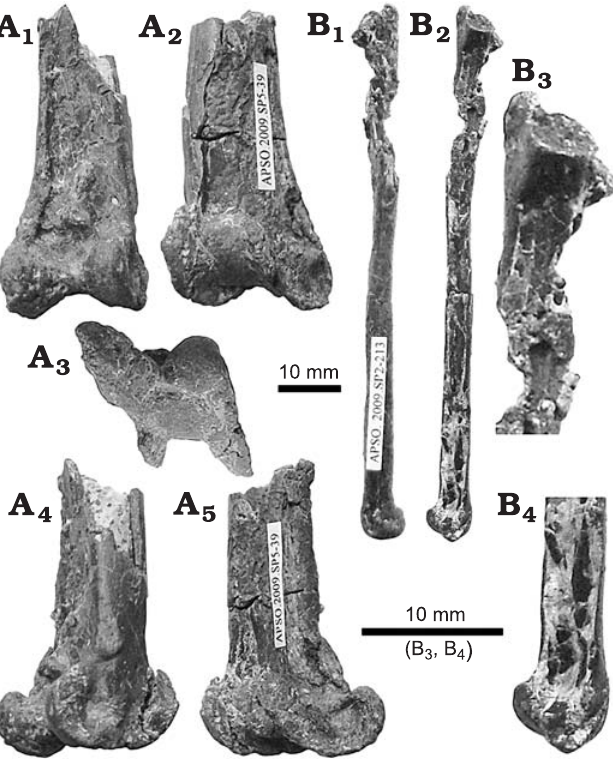
Fig. 5. Limb bones of early Eocene birds, La Borie, France. A . Geranoidid Galli geranoides boriensis gen. et sp. nov., left tibiotarsus, MHNT. PAL.2013.16.3 (holotype), in cranial (A ), caudal (A ), distal (A ), lat- 1 2 3 eral (A ), and medial (A ) views. B . Undetermined bird, left ulna, MHNT. 4 5 PAL.2013.16.4, in dorsal (B ), ventral (B ), proximal part in ventral (B ) 1 2 3 and distal part in ventral (B ) 4